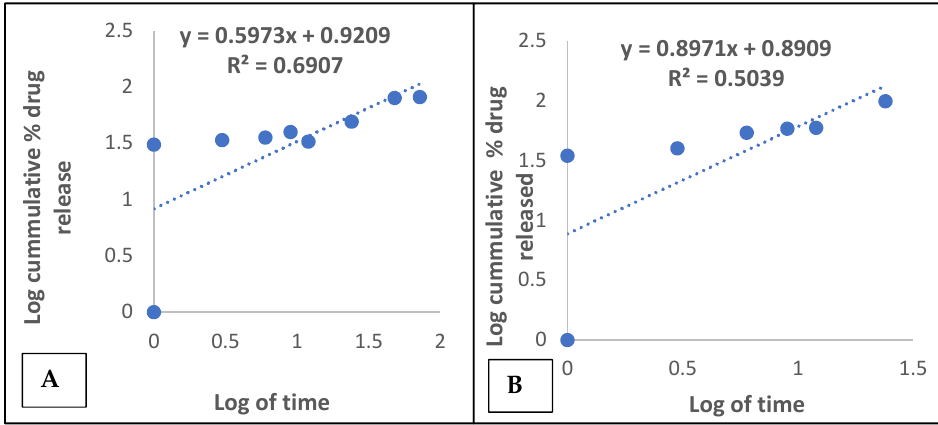
Figure 2: (A) Korsmeyer-peppas model kinetic release of tenofovir from microspheres. (B) Figure 2. ( A ) Korsmeyer-peppas model kinetic release of tenofovir from microspheres. ( B ) Korsmeyer- Korsmeyer-peppas model kinetic release for tenofovir from microspheres facilitated with enzymes peppas model kinetic release for tenofovir from microspheres facilitated with